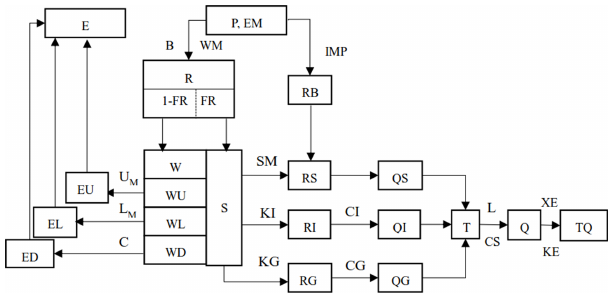
Figure 2. Framework of the Xin’anjiang Model. Note: K : Reduc-